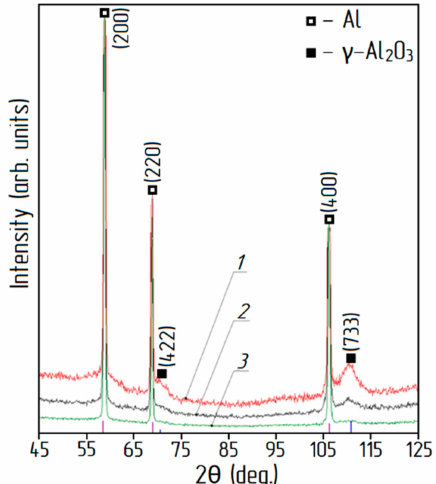
Figure 7. XRD patterns of aluminum-alumina powdery composites: 1) 20.0 wt. % Al 2 O 3 , 2) 14.5 wt. % Al 2 O 3 , 3) 10.0 wt. % Al 2 O 3 .